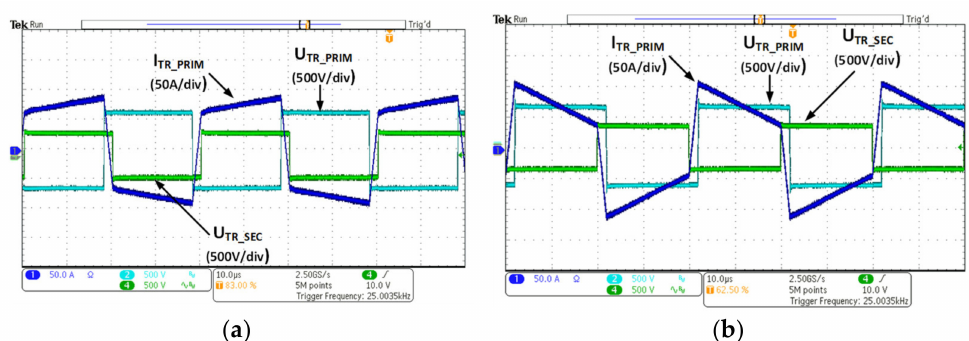
Figure 17. Operation of the dual active bridge (DAB) in the bidirectional charger (reduced time scale)—steady state: ( a ) charging mode, ( b ) discharging mode, from the top: transformer current at the primary side (dark blue), voltage of the primary side (light blue), voltage of the secondary side (green).